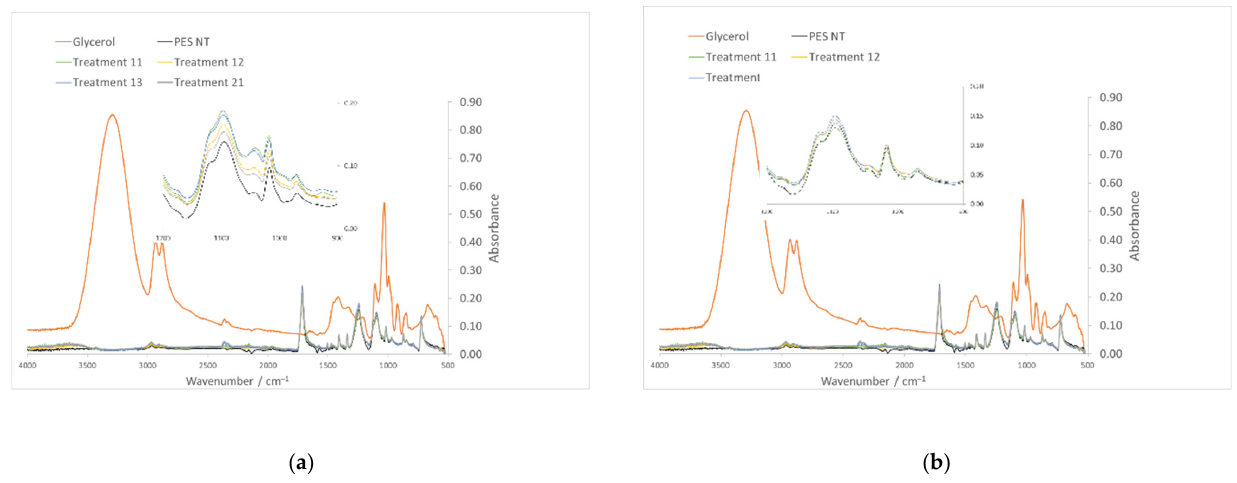
Figure 1. ATR-FTIR spectra of PES, GL, nontreated PES and GL-treated PES fibers (Table 3) before ( a ) and after rinsing ( b ).